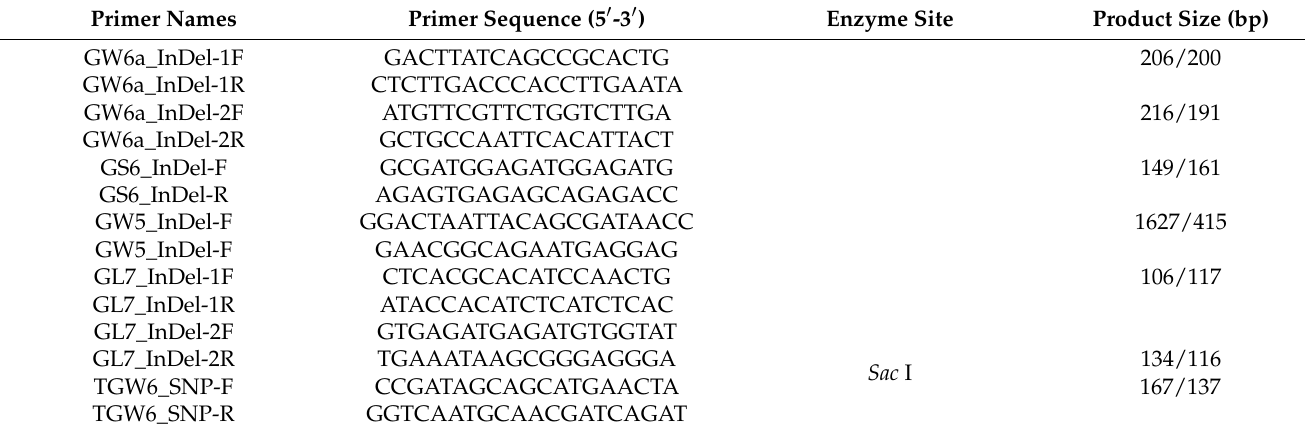
Table 1. Primer information on the seven functional markers targeting five grain-size